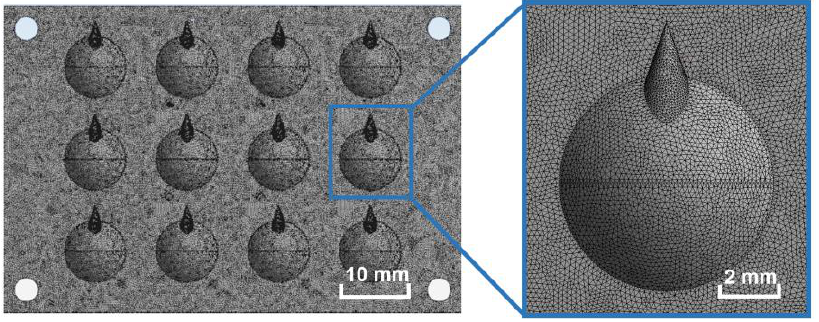
Figure 4. Mesh generation of geometrical model.